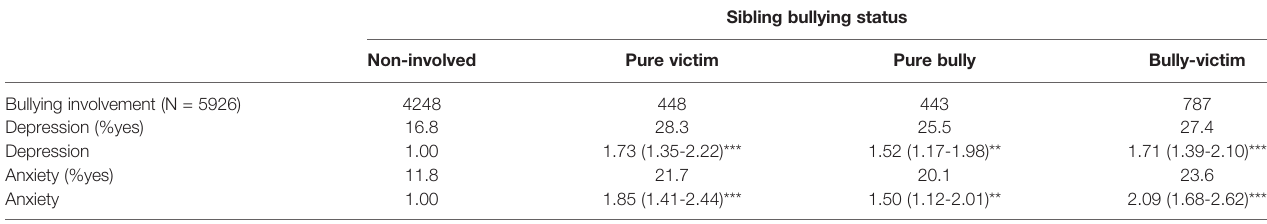
TABLE 2 | The associations between sibling bullying status and depression and anxiety [Adjusted OR (95% CI)].